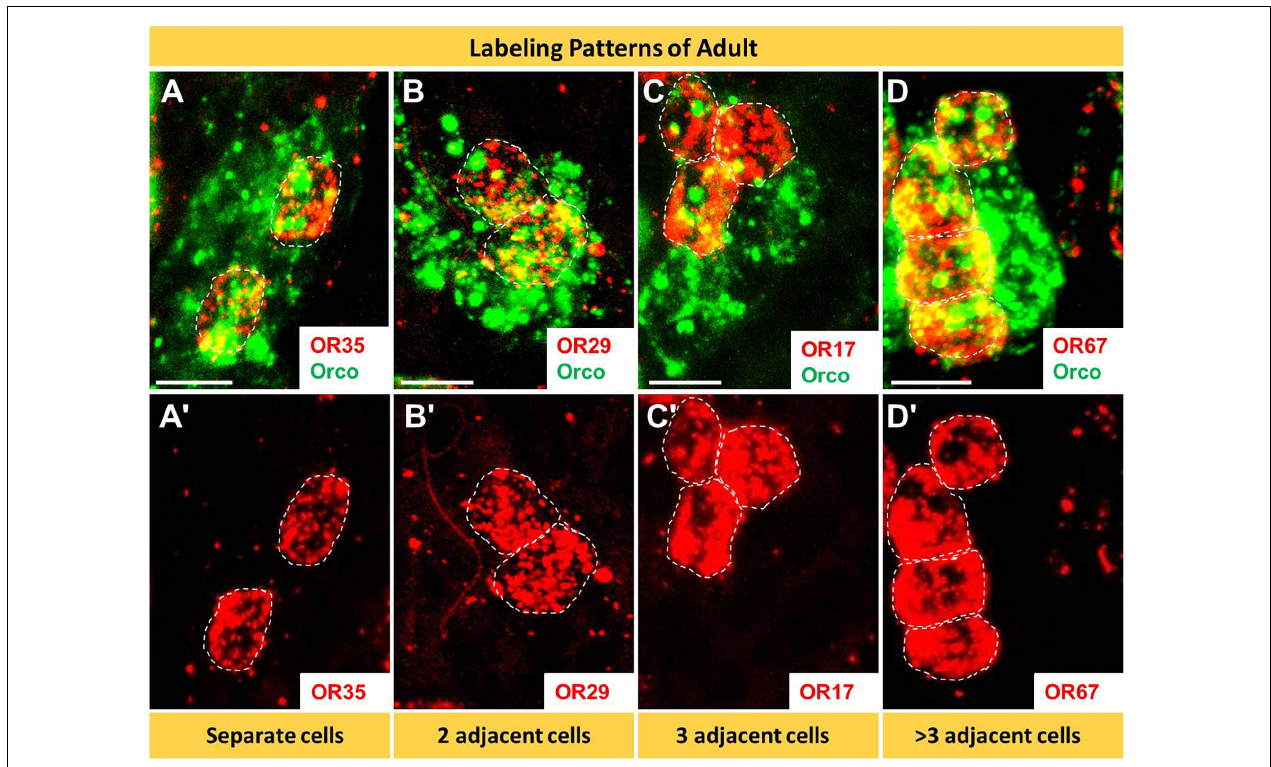
FIGURE 6 | In basiconic sensilla distinct OR types are expressed in several cells. The cells expressing distinct OR types and Orco were visualized by means of two-color FISH using specific antisense riboprobes. (A–D’) The analyses of 10 µ m optical stacks revealed four different patterns of OR expression; ranged from solitary cells to multicellular clusters. White dash circles outline cell expressing the distinct OR type. Scale bars, 10 µ